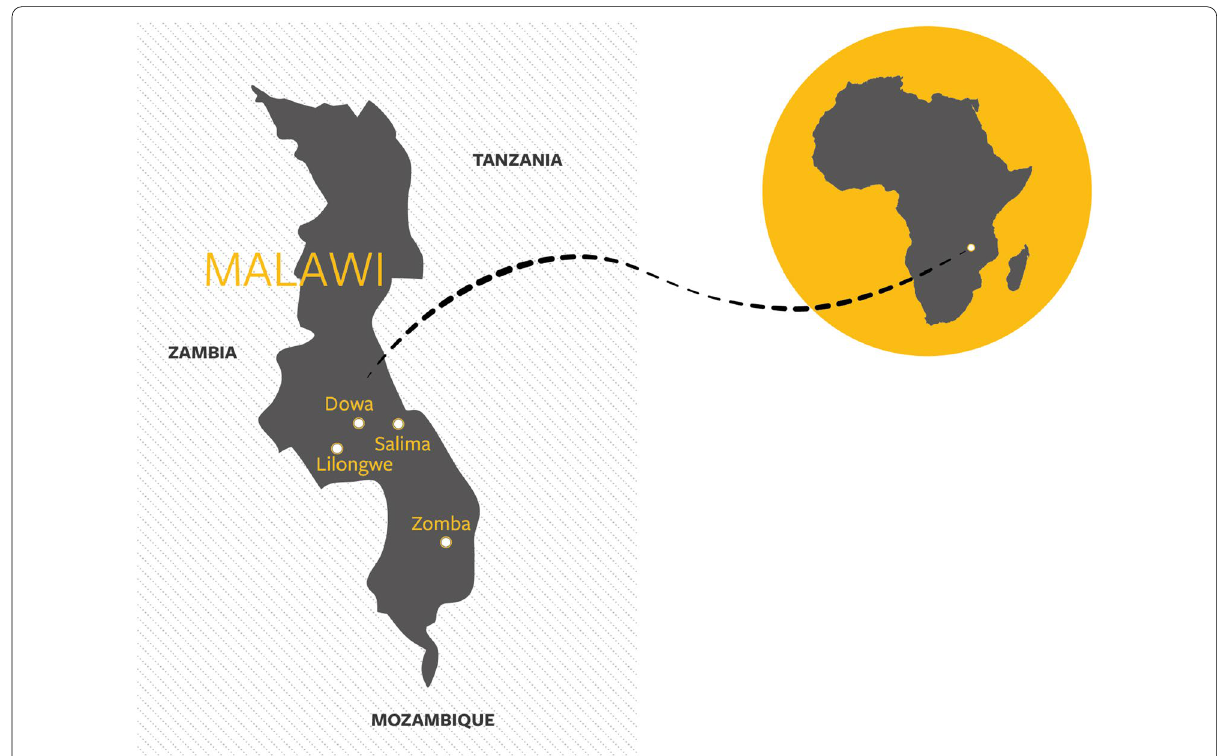
Fig. 1 Map of study locations in